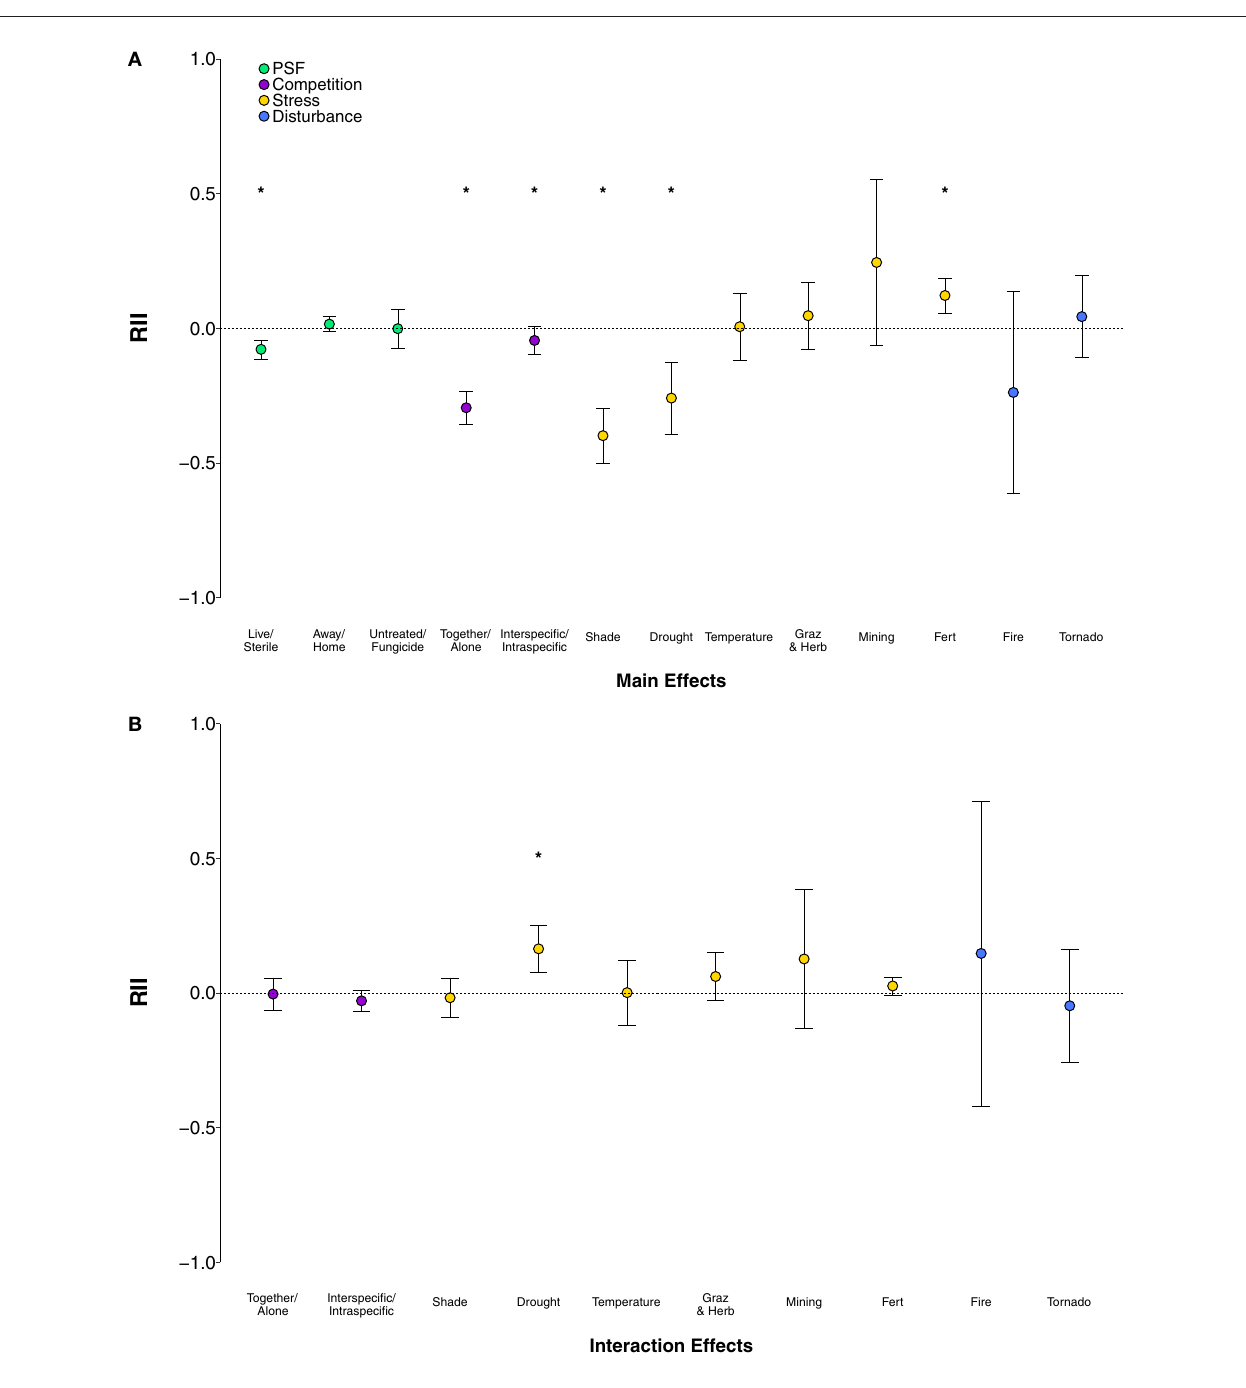
FIGURE 2 | (A) Main effects of PSF, competition, stress, and disturbance manipulations and (B) interaction effects of PSF x competition, PSF x stress, and PSF x disturbance manipulations on plant growth, averaged across soil manipulations (live/sterile, away/home, untreated/fungicide). Error bars represent lower and upper bounds of the confidence intervals. Asterisks indicate effect sizes significantly different from zero.